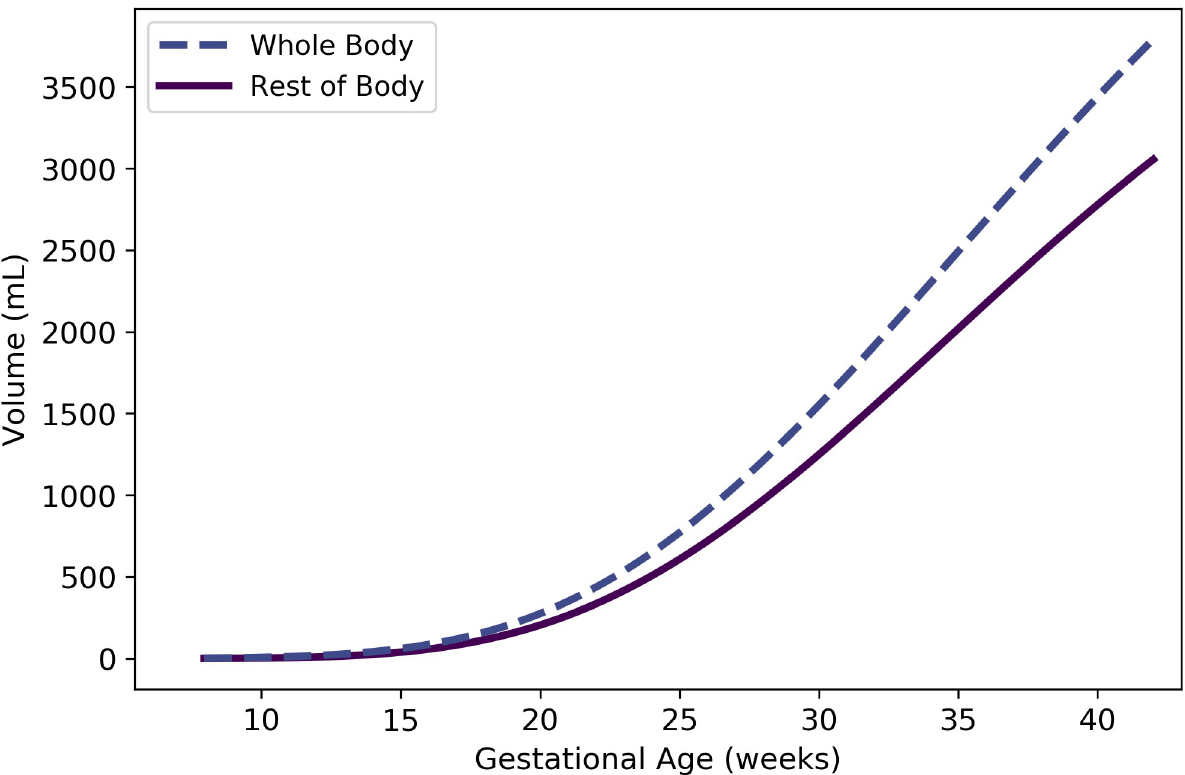
Fig 21. Fetal rest of body vs. gestation age (cf. Eq 43). The volume of the whole fetal body (cf. Eq 2) is shown for comparison.